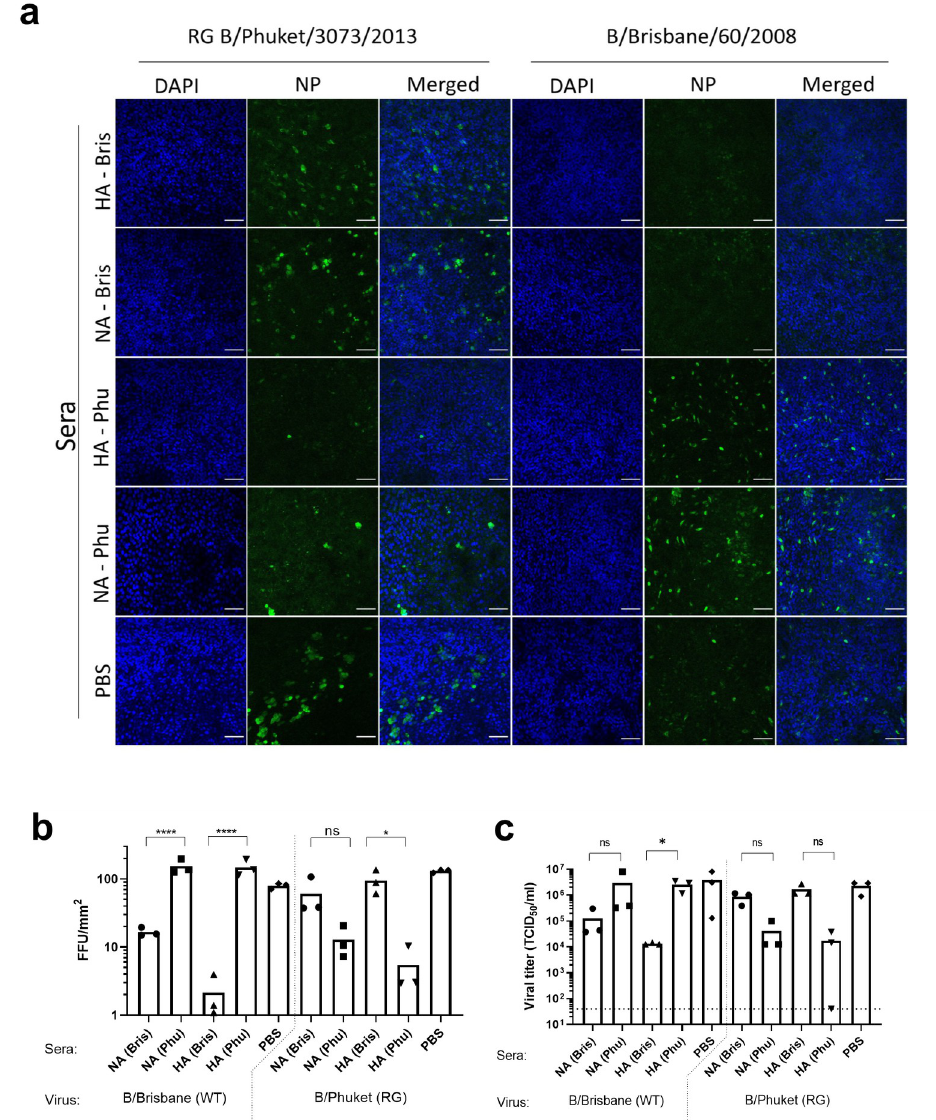
Fig 5. Homologous anti-HA and anti-NA immune serum restricts IBV infection of HAE cells. HAE cells were infected with RG B/Phuket/3073/2013 or B/Brisbane/60/2008 in the presence of the indicated anti-NA, anti-HA or PBS mouse serum. (a) Infection was imaged by NP staining. (b) The number of focus-forming units (FFU) were quantified using QuPath 0.3.0 software. (c) Titers of virus present in washes of the apical side of the HAE cells taken at 24 after infection. � P < 0.05 and ���� P < 0.0001 (one-way